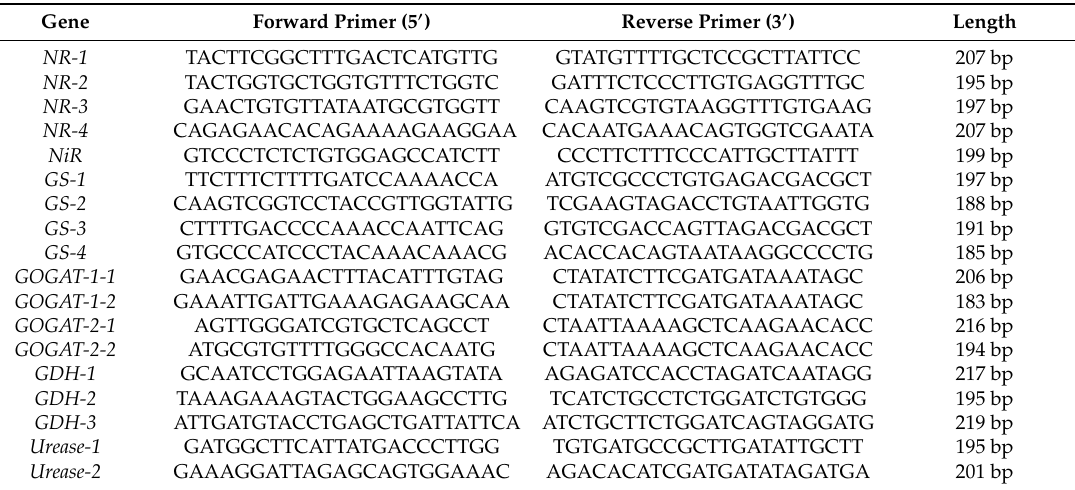
Table 3. Primer sequences for